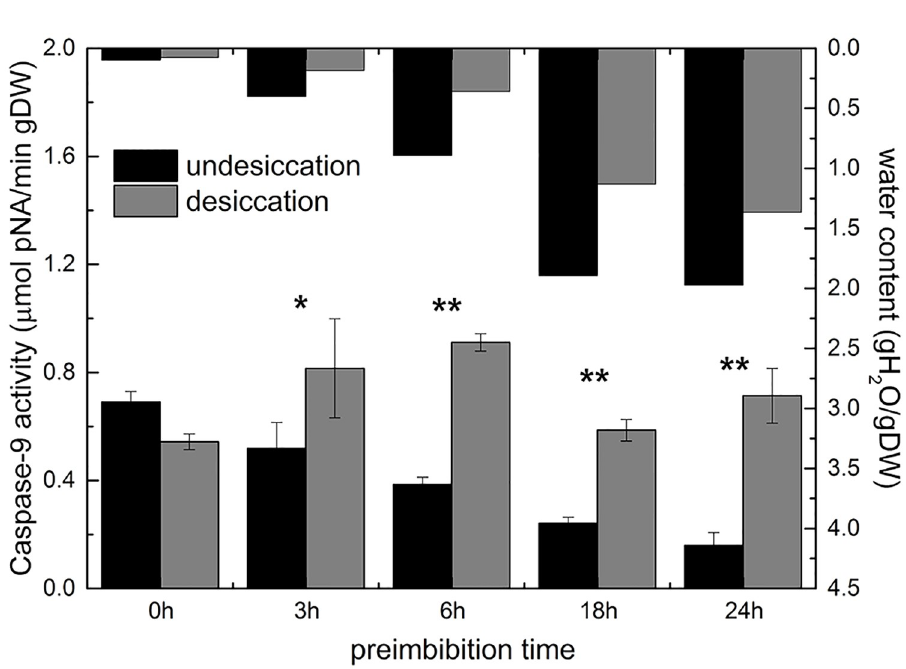
Fig 10. Activity of caspase-9 in mung bean hypocotyls in different preimbibition and dehydration states. � P < 0.05; �� P < 0.01.